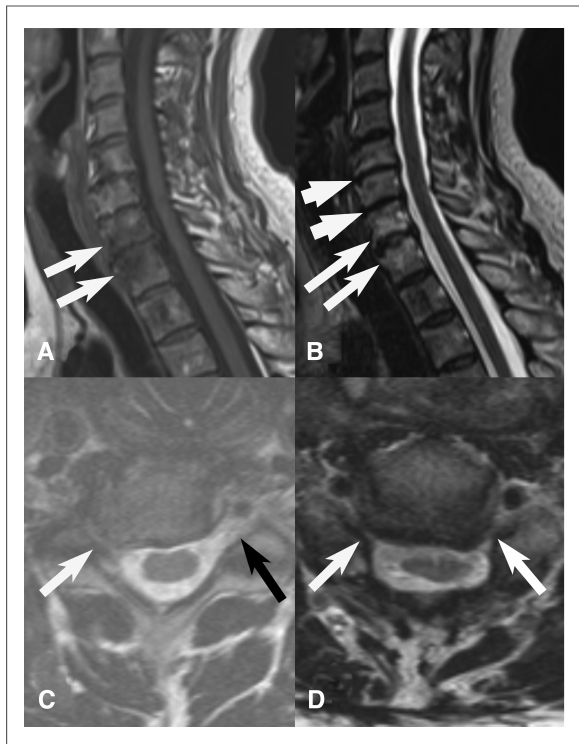
FIGURE 3 MRI of three different patients. ( A,B ) T1W-, and T2W sagittal images show Modic type 1 changes with bone marrow oedema around C7- Th1-disc space (thin long arrows) and moderate disk degeneration C5 – C6 and C6 – C7 (thick short arrows). ( C ) T2W axial image shows right sided foraminal stenosis C6 – C7 with severe narrowing of neural foramen compression (white arrow) and C7-nerve root. Black arrow shows normal left neural foramen. ( D ) T2W axial image shows bilateral foraminal stenosis at C5 – 6 level with C6- nerve root